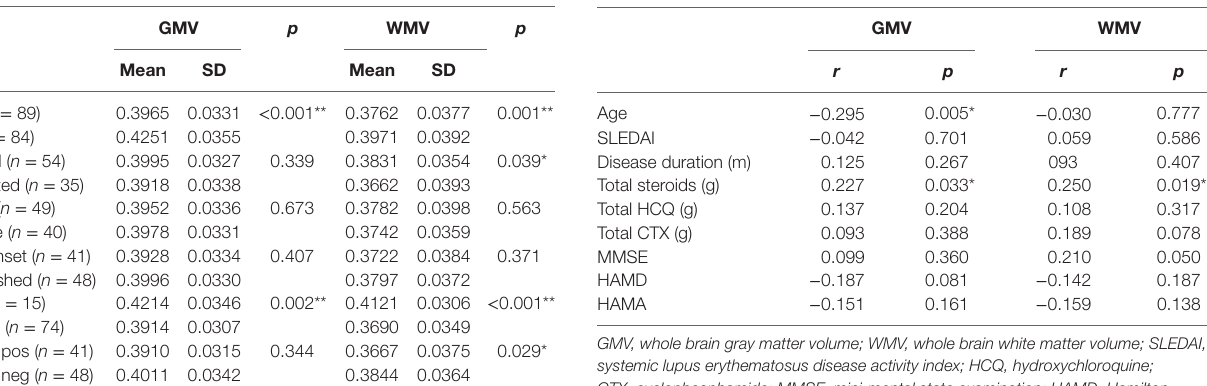
TaBle 3 | Correlation between GMV/WMV and clinical characters. TaBle 2 | GMV and WMV differences between different